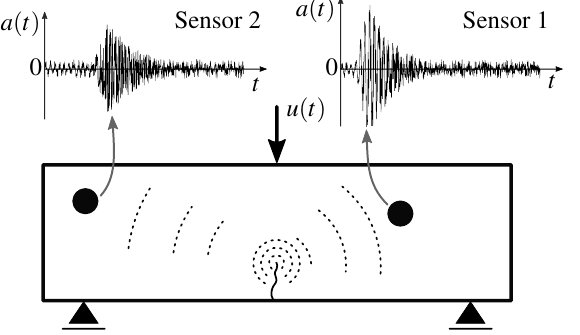
Figure 1. Basic setup for acquiring AE signals, with two AE sensors. Although both signals refer to the same event, they differ according to their positions along the